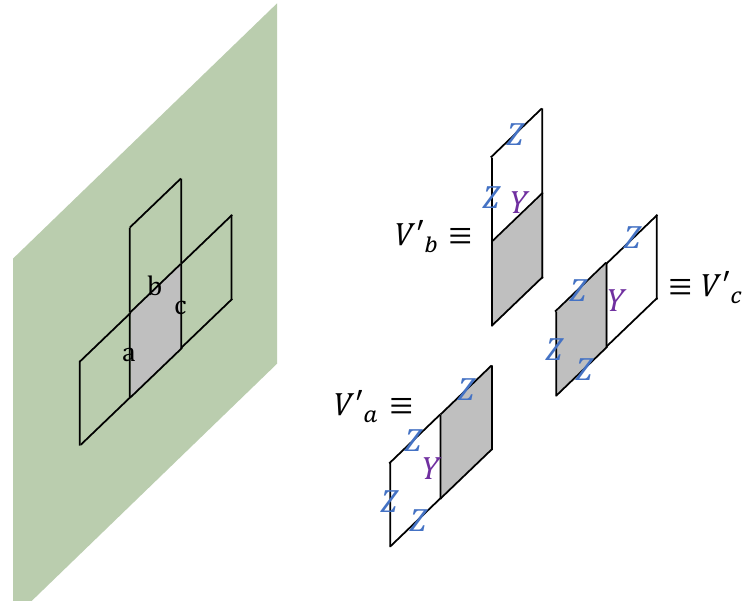
Figure 12: The T junction process for the fermion hoppping operator on the intersec- tion of the loop creation operator and the domain wall: V ′ implies that the loop excitation is